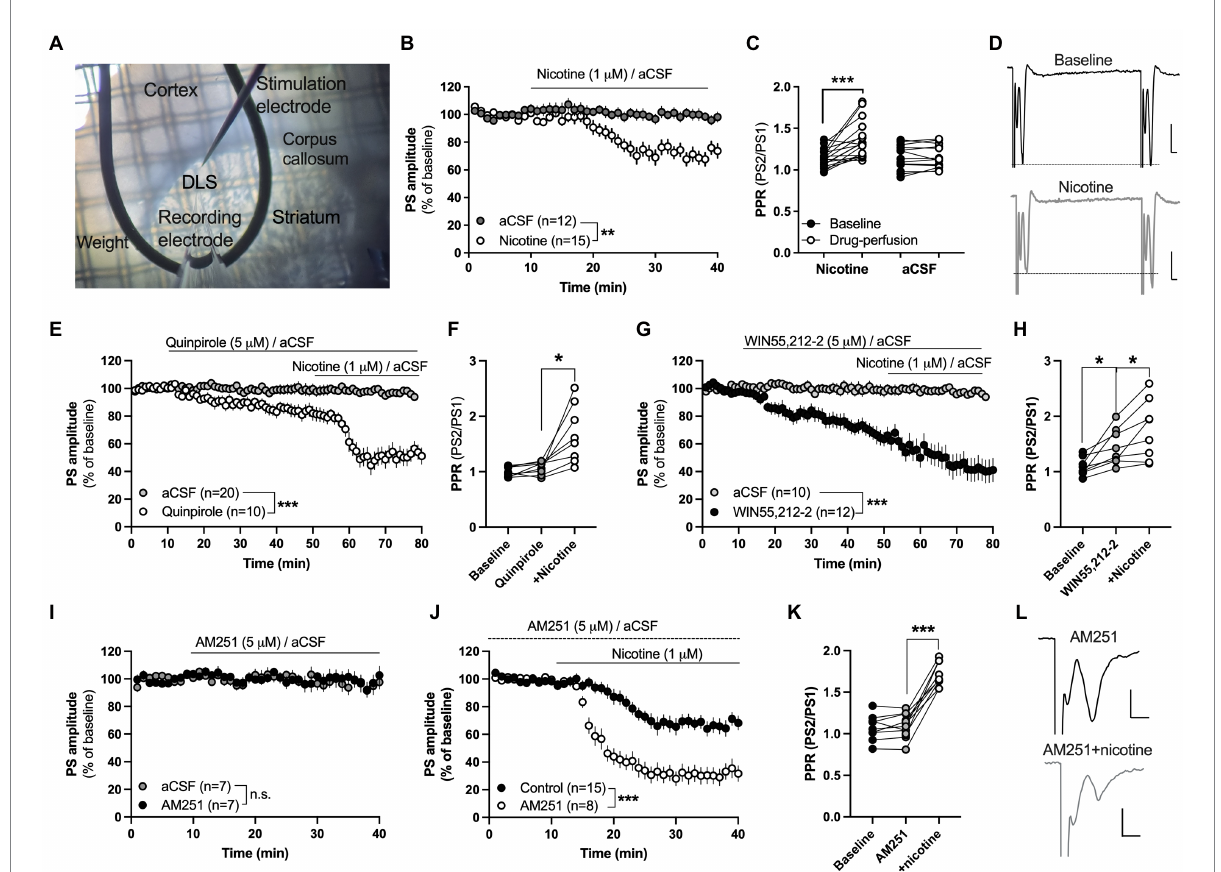
FIGURE 1 Acute nicotine exposure depresses evoked potentials and promotes HFS-LTD in the female rat striatum. (A) Micrograph showing the position of recording and stimulation electrode in the DLS. Recording and stimulating electrodes were positioned close to the corpus callosum in the lateral part of the dorsal striatum. Note the visual texture of the striatum and the dark shade of the corpus callosum which clearly marks the transition to the cortex. (B) Evoked field potentials were significantly depressed by bath perfusion of nicotine (1 μ M). (C) Nicotine perfusion significantly increased PPR. (D) Example traces showing field potentials evoked with a paired pulse stimulation protocol delivered with a 50 ms interpulse interval at baseline (upper trace) and after 25 min nicotine perfusion (lower trace). Note that the first pulse decreases to a greater extent in response to nicotine perfusion, thereby resulting in increased PPR. Calibration: 0.2 mV, 2 ms. (E,F) The dopamine D2 receptor agonist quinpirole (5 μ M) slightly depressed PS amplitude but did not occlude nicotine-induced synaptic depression or the increase in PPR. (G,H) Bath perfusion of the CB1R agonist WIN55,212-2 (3 μ M) significantly depressed PS amplitude and increased PPR, and nicotine co-perfusion further potentiated synaptic depression. (I) The CB1R antagonist AM251 (3 μ M) did not modulate PS amplitude by itself. (J) Synaptic depression induced by acute nicotine perfusion was significantly enhanced in AM251-pretreated slices. (K) PPR was not modulated by AM251, but robustly enhanced when nicotine was co-administered. (L) Example traces showing evoked PS amplitude at AM251-treated baseline (upper trace) and following nicotine co-perfusion (lower trace). Not that the pre pulse is not affected during nicotine co-perfusion demonstrating that nicotine affects synaptic transmission. Data are mean values ± SEM. n = number of slices, taken from at least three animals. * p < 0.05, *** p <